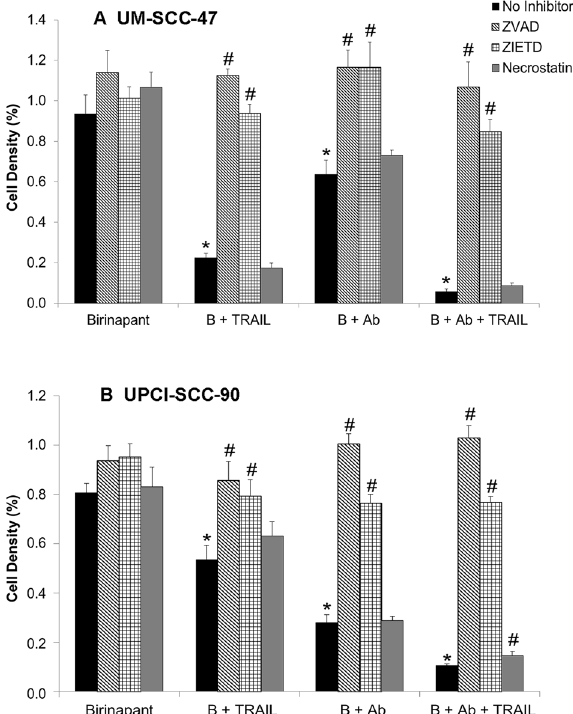
Figure 7. Caspase inhibitors reverse the antiproliferative effect of birinapant and combination treatments. UM-SCC-47 ( A ) and UPCI-SCC-90 cells ( B ) were treated with birinapant alone and combined with TRAIL, TRAILR2 antibody, or a triple combination. Twenty μg/mL of pan-caspase inhibitor ZVAD, caspase-8 inhibitor ZIETD, or RIPK1 inhibitor Necrostatin were added, and cell density was measured by XTT at 72 h for UM-SCC-47 cells and at 120 h for UPCI-SCC-90 cells. Independent experiments were performed to titrate the drug doses, the drug combinations, and time points previously. Error bars, the standard deviation of 6 replicates from a representative of independent experiments. * denotes a significant difference when compared each condition of combinatory treatment with Birinapant alone without caspase or necrosis inhibitors (comparison of other black bars to the first black bar). # denotes the statistical significance showing the caspase and necrosis inhibitors’ effects in each treatment group (other bars compared to the black bars). Student’s t test, p <